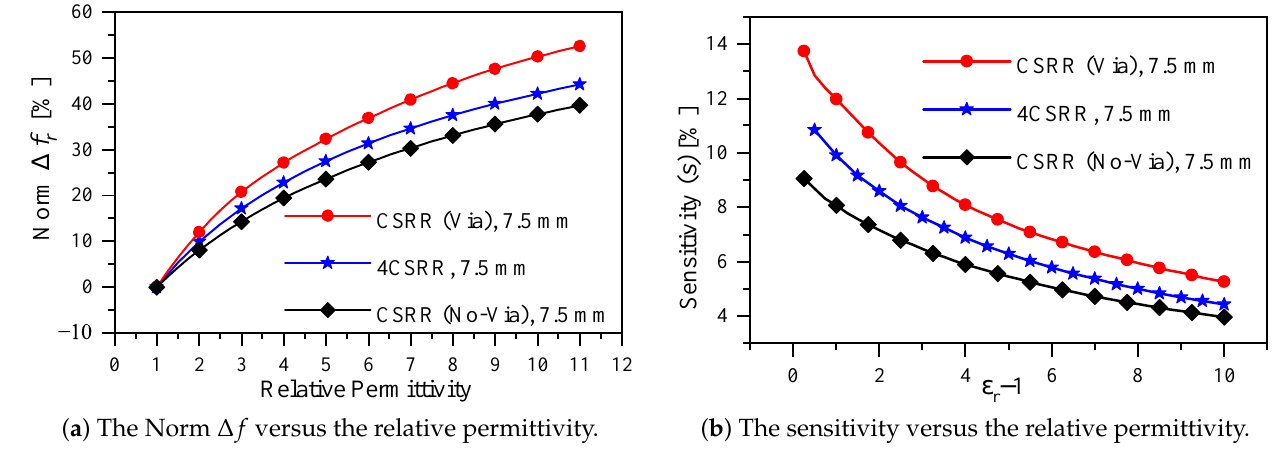
Figure 8. The sensor evaluation using (4) and (5), ( a ) the normalized resonance frequency shift versus the relative permittivity for three cases: the original CSRR sensor (no via), the 4CSRR sensor, and the proposed CSRR sensor (with via), whereas ( b ) the sensitivity versus the relative variation in the permittivity for three cases: the original CSRR sensor (no via), the 4CSRR sensor, and the proposed CSRR sensor (with